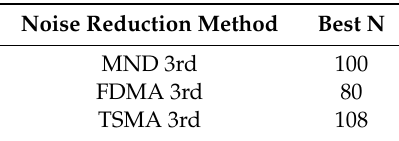
Figure 7. The maximum SNR distribution according to various values of N (TSMA) . Table 2. The best Ns for MND, FDMA, and TSMA .